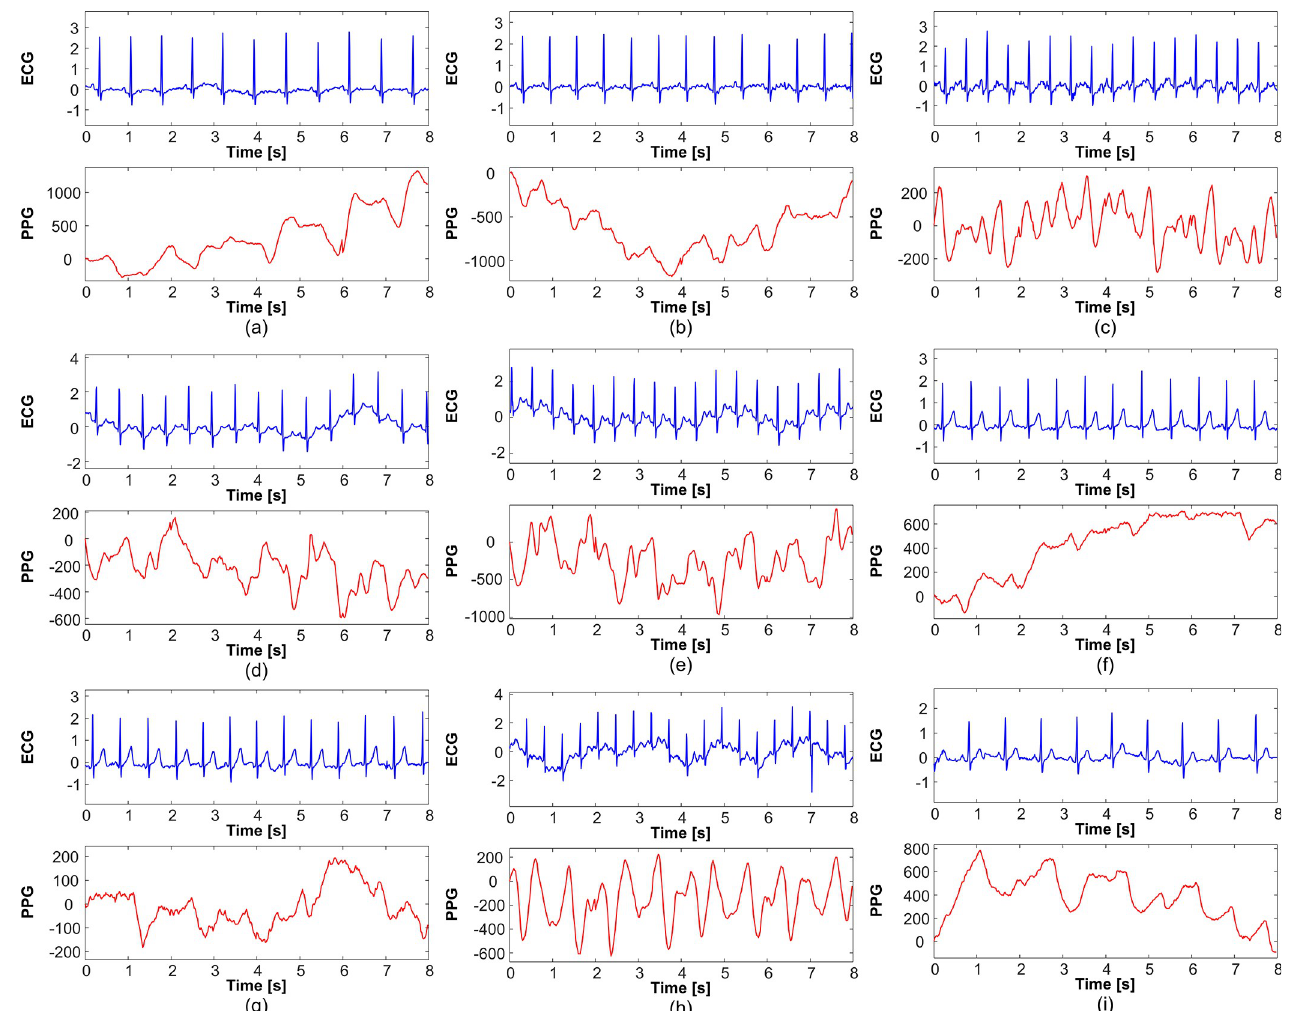
Fig 10. Examples of PPG signals corrupted by MAs. (a)–(i) show PPG signals corrupted by different MAs. There are numerous MA patterns in PPG signals.